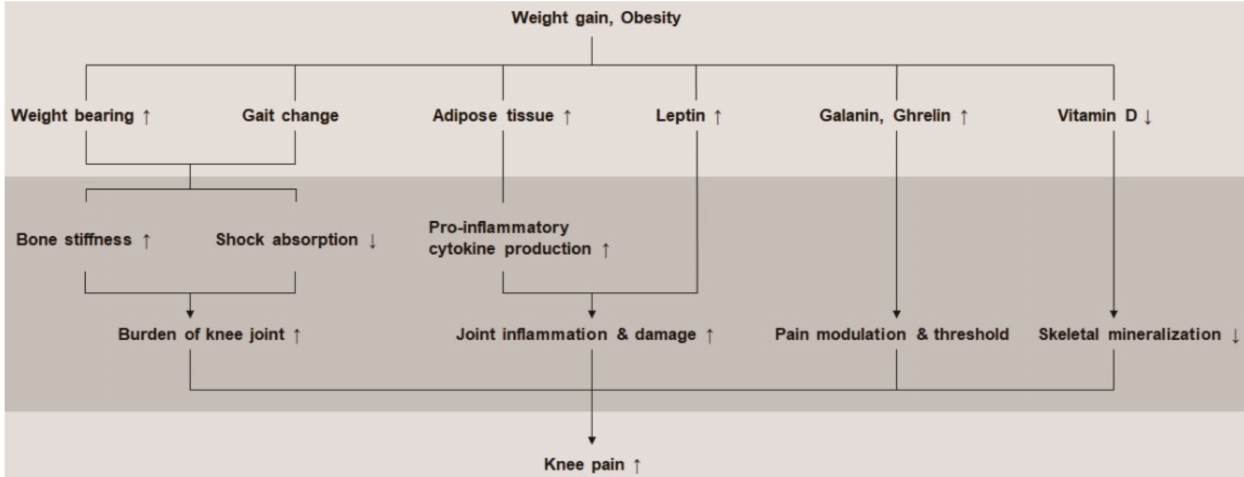
Figure 3. Theory regarding the pathophysiological effects of weight gain and obesity on knee